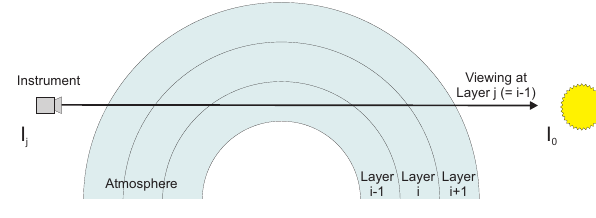
Fig. 1. The solar occultation viewing